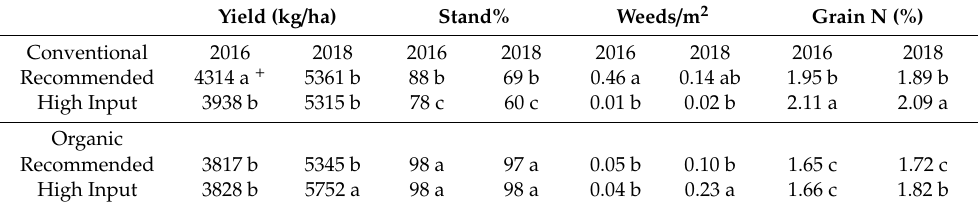
Table4. Grainyield, stand%(10–15daysafterplanting), weeds / m 2 (earlyspring), andgrainN%ofwheat in 2015–2016 and 2017–2018 under conventional and organic cropping systems with recommended and high input management at a University Research Farm in central New York,